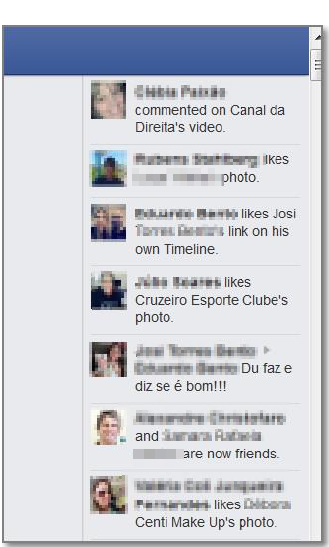
Fig. 1. Facebook ticker interface.